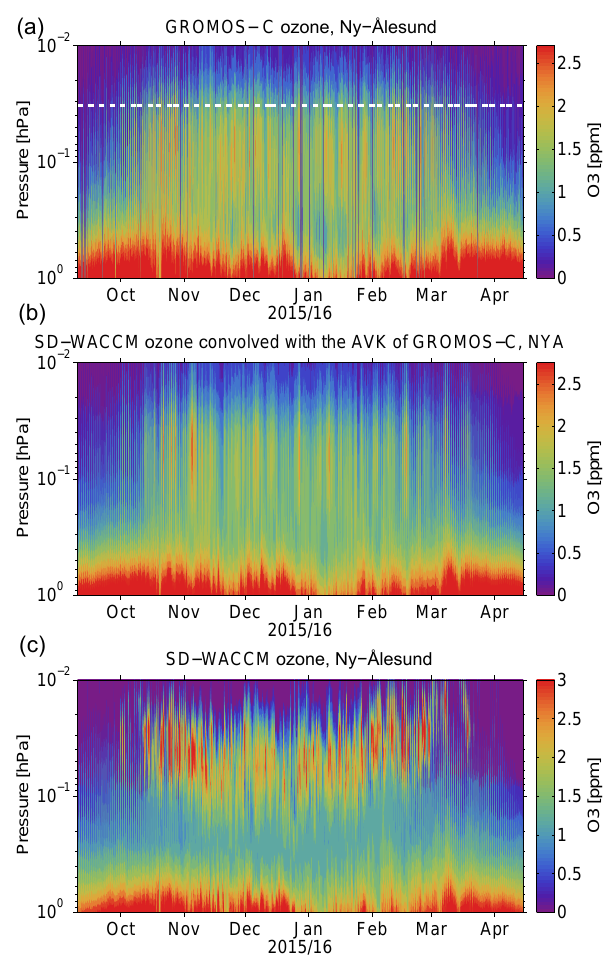
Figure 16. The tertiary ozone maximum at Ny-Ålesund measured by the ground-based microwave radiometer GROMOS-C (a) . The dashed white line indicates the measurement response of 0.8. Sim- ulation of the tertiary ozone maximum by SD-WACCM convolved with the averaging kernels of GROMOS-C (b) and unconvolved (c) .